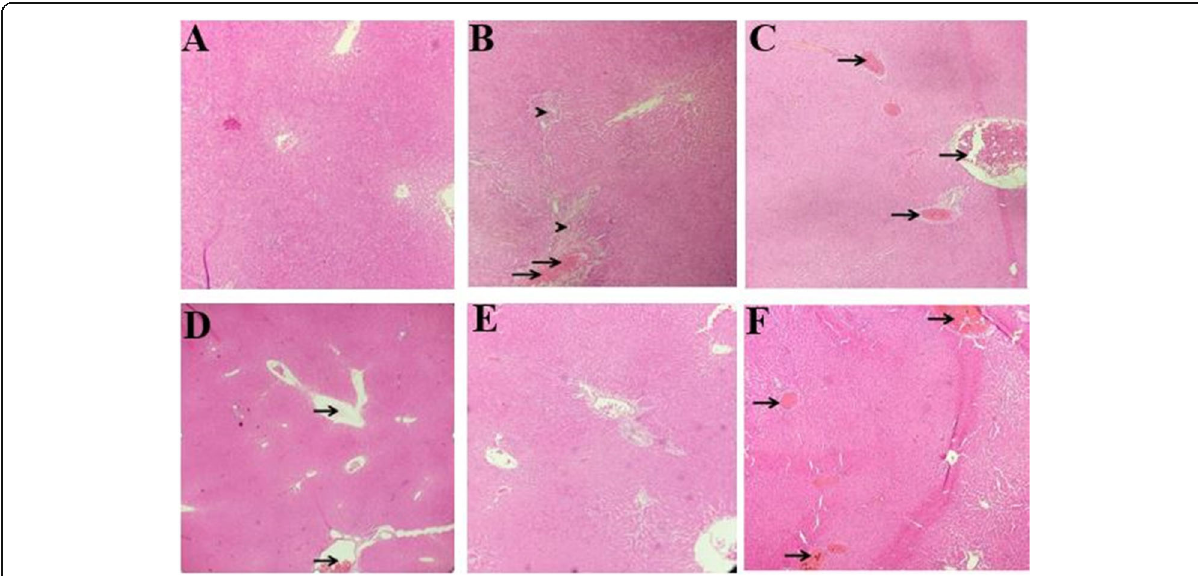
Fig. 6 Histological photomicrographs of liver samples from Wistar rats with Lead acetate-induced toxicity and treated with PLEE (Mag., X100). A (Control group): No visible lesions seen; B (Lead only): There is a mild to moderate congestion of the portal vessels (arrows). There appears to be a mild periportal fibroplasia (arrowheads ); C (Lead + PLEE (1): There is a moderate to severe portal and central venous congestion; D (Lead + PLEE (2): There is mild congestion of the portal vessels; E (PLEE (1) No visible lesions are seen; F (PLEE (2): There are mild portal and central venous